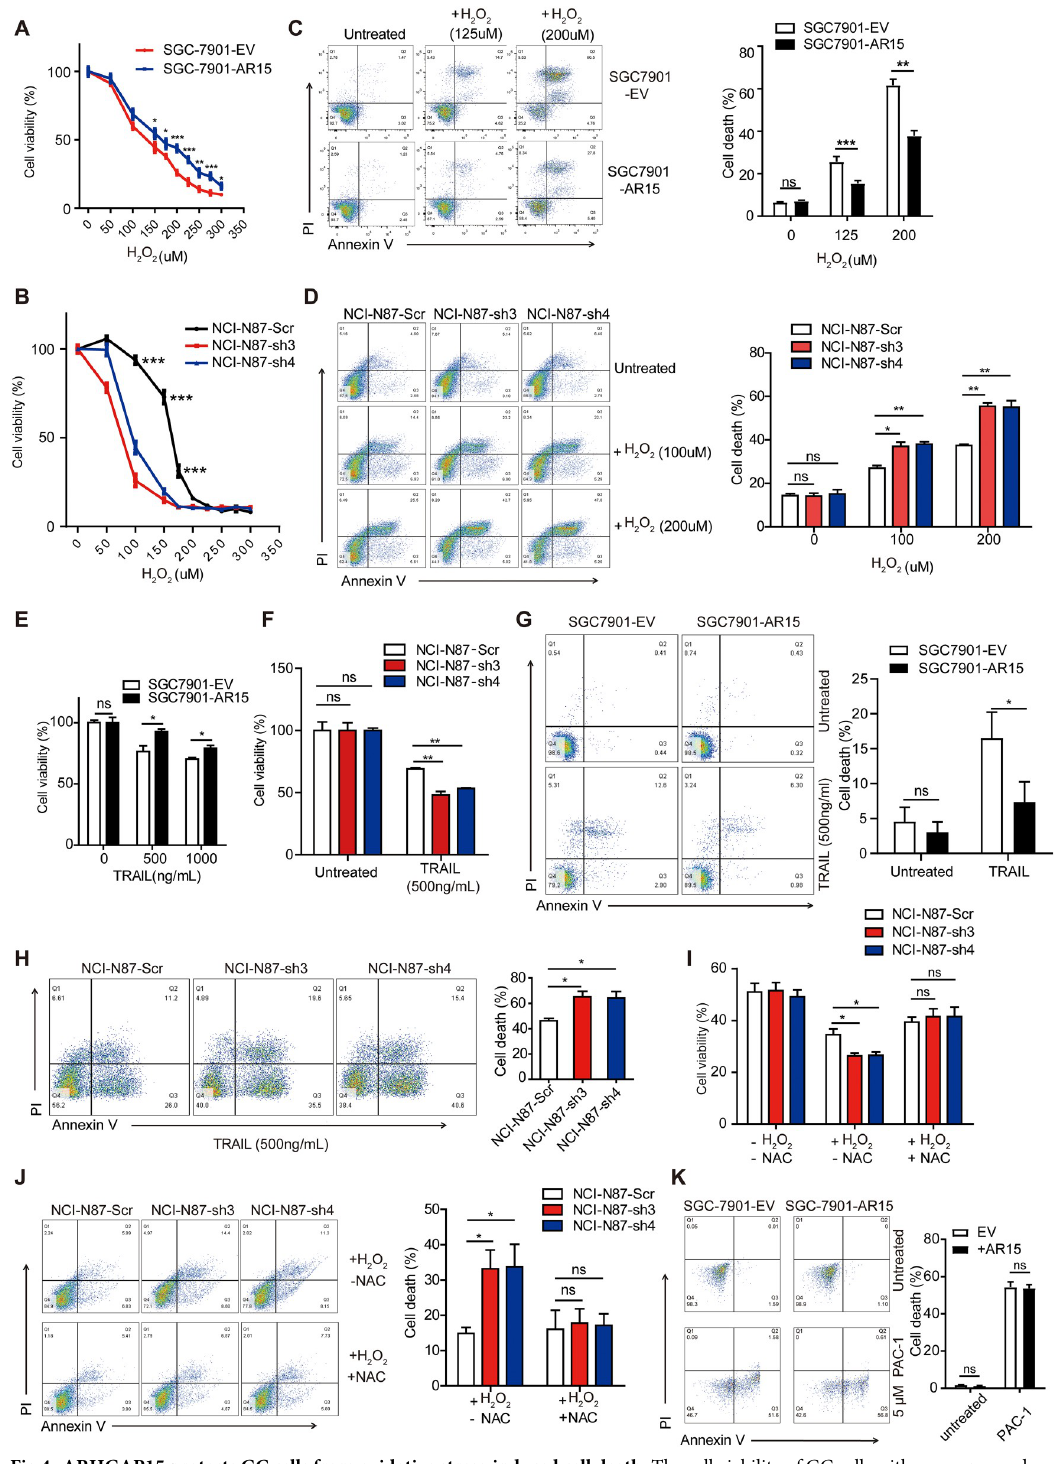
Fig 4. ARHGAP15 protects GC cells from oxidative stress-induced cell death. The cell viability of GC cells with overexpressed ARHGAP15 ( A ) or silenced ARHGAP15 ( B ) under different concentration of H 2 O 2 was determined by XTT assay. (C-D) : The proportion of dead cells was determined by flow cytometry after dual staining of Annexin V and PI. (C): The cell death status of SGC7901 cells with or without ARHGAP15 overexpression under the treatment of indicated H 2 O 2 concentration. (D): The cell death status of NCI-N87 cells with or without silenced ARHGAP15 under the treatment of indicated H 2 O 2 concentration. (E-F) : The GC cell viability after TRAIL treatment was evaluated by XTT assay. (E): The fraction of survived SGC7901 cells with or